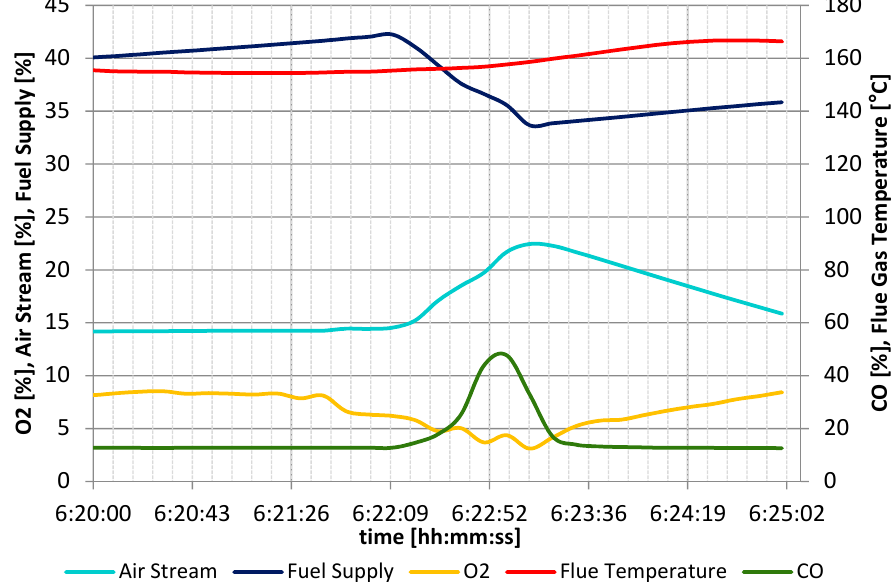
Figure 9. The combustion control based on the trend of CO emissions.